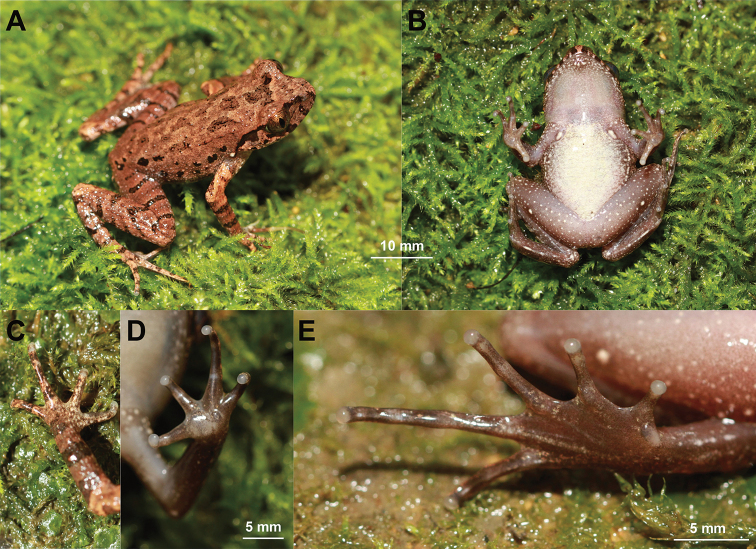
Photos of the holotype CIBCS20190518047 of Leptobrachella
chishuiensis sp. nov. in life A dorsal view B ventral view C dorsal view of hand D ventral view of hand E ventral view of foot.